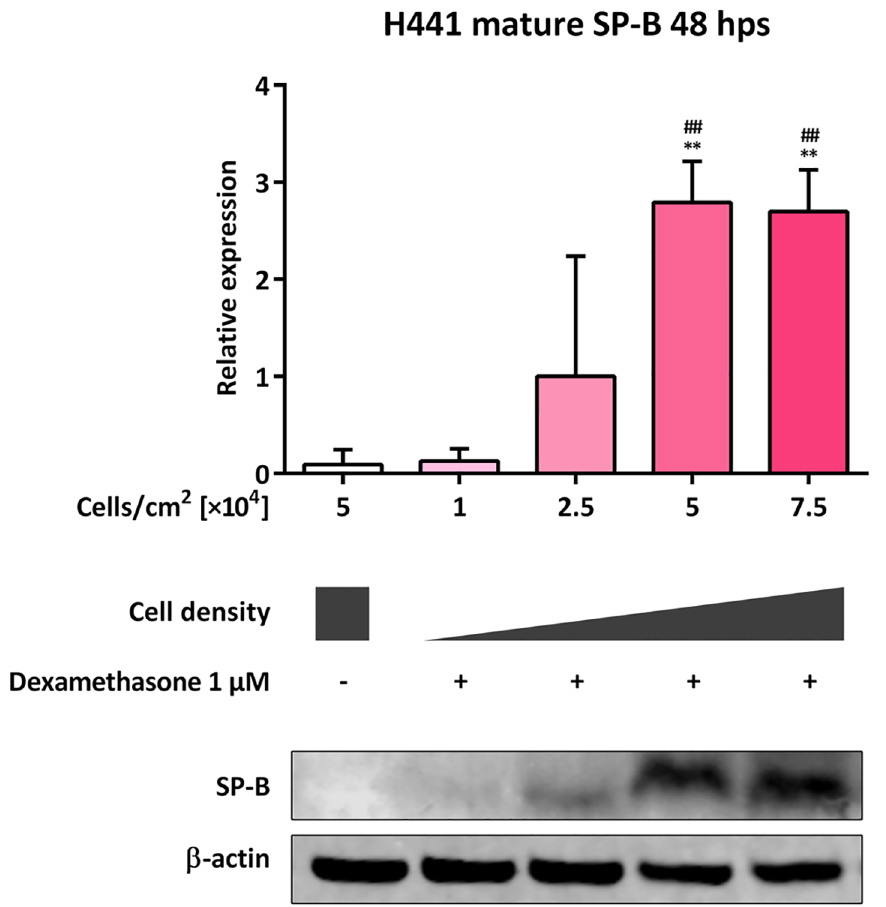
Fig 2. Impact of cell density on mature SP-B expressionin H441 cells. Different quantitiesof H441 cells were seeded as indicatedand either left untreated or incubatedwith 1 μ M dexamethasone. After 48 h immunoblotting against SP-B and β -actin was performed. SP-B levels were normalized to β -actinand fold differences comparedto 2.5 × 10 4 dexamethasone-treated cells per cm 2 were calculated. Means +SD of n = 3 independent experiments are shown. ** p < 0.01 comparedto 5 × 10 4 untreatedcells per cm 2 , ## p < 0.01 comparedto 1 × 10 4 dexamethasone-treatedcells per cm 2 .